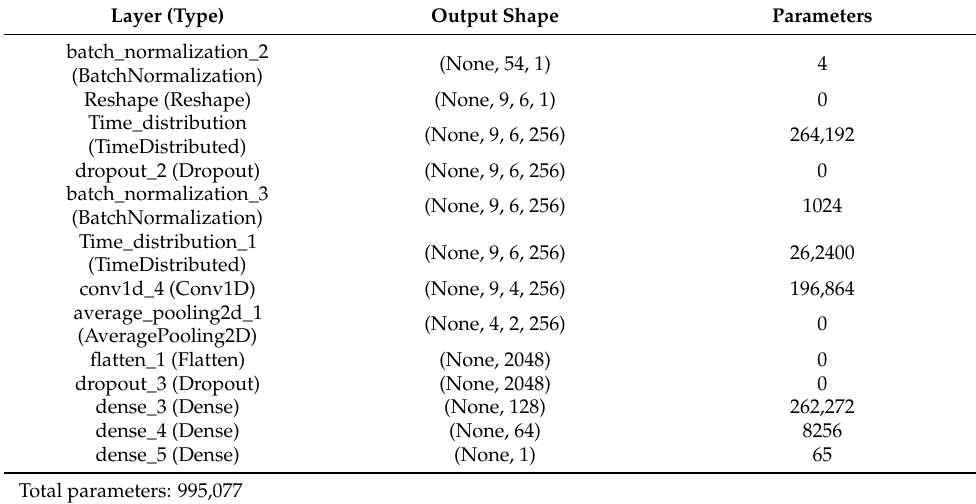
Table 4. Architecture and parameter settings of the CV-LSTM+CNN model.